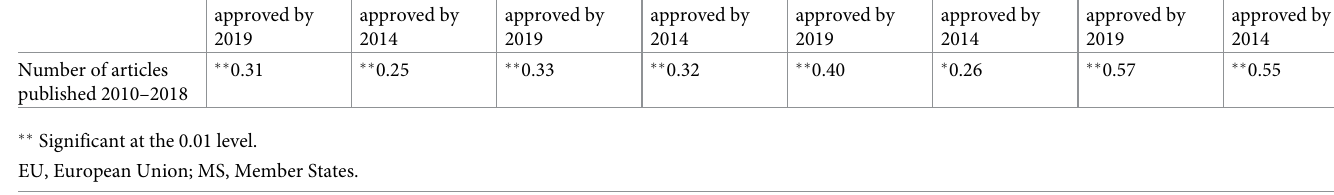
Table 1. 2 : AU : AbbreviationlisthavebeencompiledforthoseusedinTable 1 : Pleaseverifythatallentriesarecorrect : The correlation between species with approved strains for biocontrol products in the EU MS and the number of biocontrol articles published between 2010 and 2018 on those species. Aureobasidium pullulans Bacillus amyloliquefaciens (formerly B.